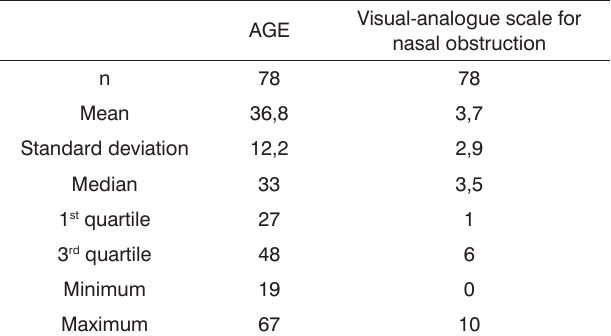
Table 1a. Sample clinical and demographic characteristics. Table 1b. Sample demographic and clinical